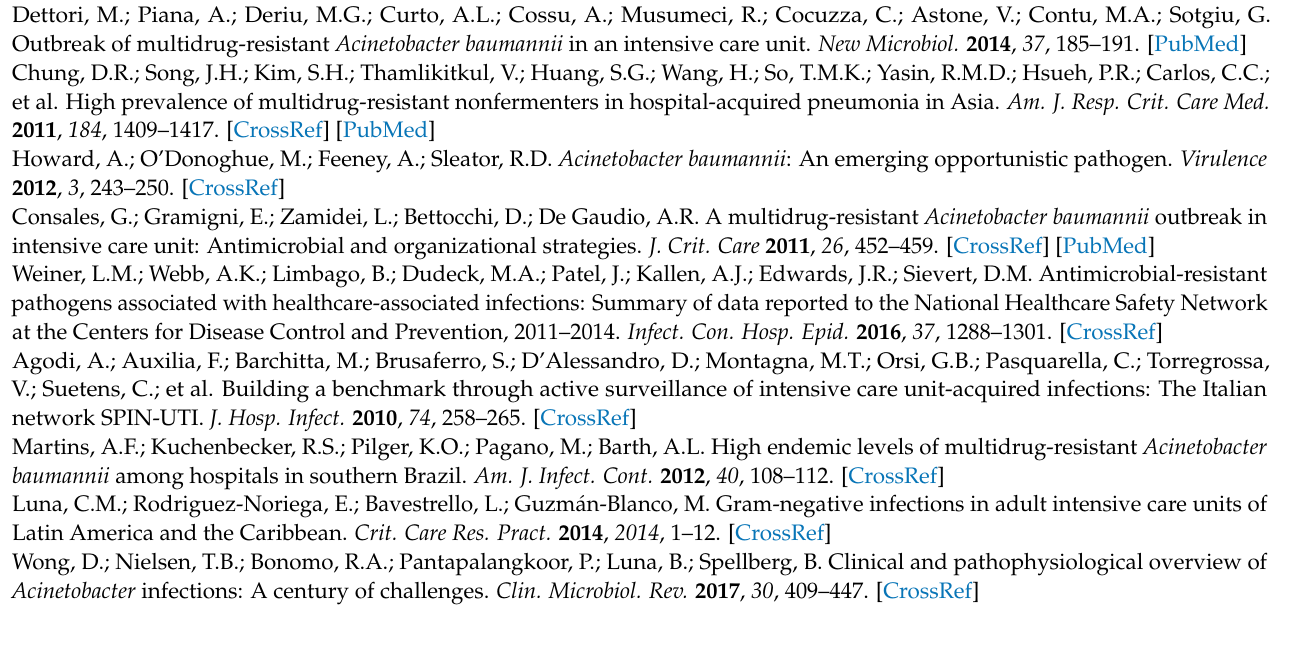
baumannii strains. Table S2: Resistance classifications of A. baumannii strains. Figure S1: Com- binatorial effects of eravacycline and ampicillin-sulbactam. Figure S2: Combinatorial effects of eravacycline and levofloxacin. Figure S3: Combinatorial effects of eravacycline and meropenem. Figure S4: Combinatorial effects of eravacycline and